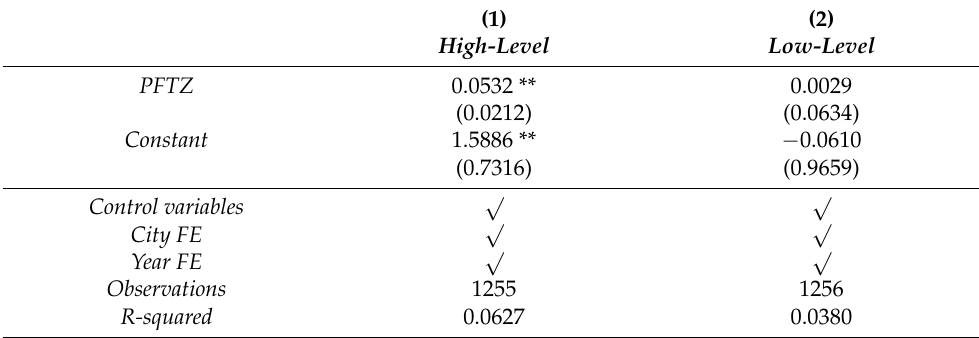
Table 10. The economic development of cities.